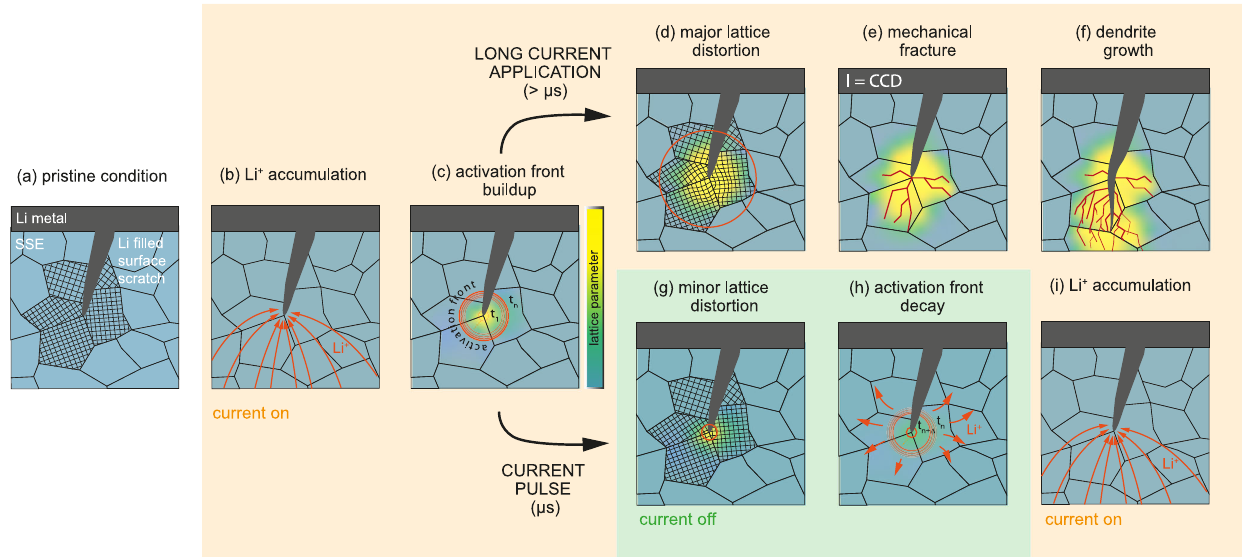
Fig. 4 | Proposed mechanisms in constant current and pulsed current elec- trochemical experiments. Flow diagram showing the proposed mechanistic dif- ferences between direct current and pulsed current ( µ s) operation of a solid-state cell employing a Li metal anode: a pristine condition of the Li|SSE interface exhi- bitingasurfacescratchoftheSSE fi lledwithLi,alongwiththelatticeorientationsof the adjacent grains near the defect tip. b Once the current is switched on Li-ions start to concentrate near the defect tip and c cause the buildup of an activation front, increasing over time t n . LLZTO is thereby locally reduced and the lattice parameter in this region changed. d In case of direct or long current pulse (> µ s)